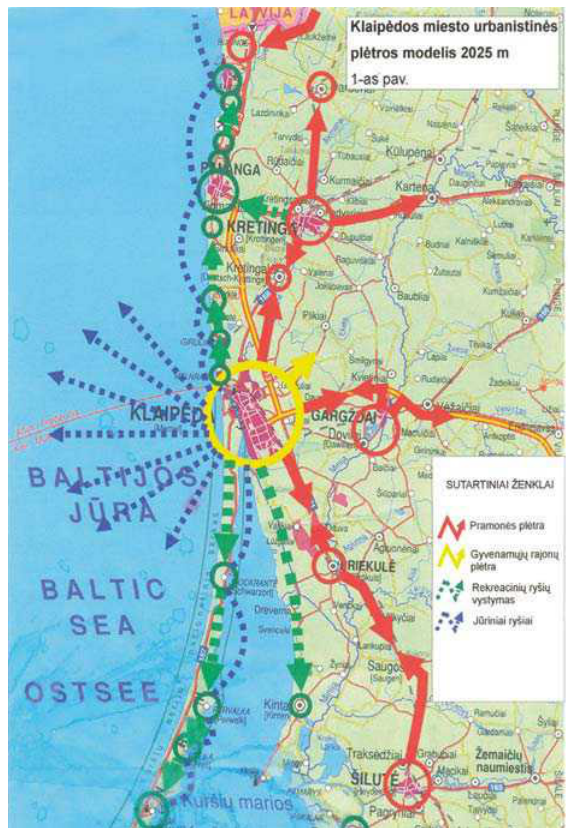
Fig 6. Development forecast of Klaipėda sea